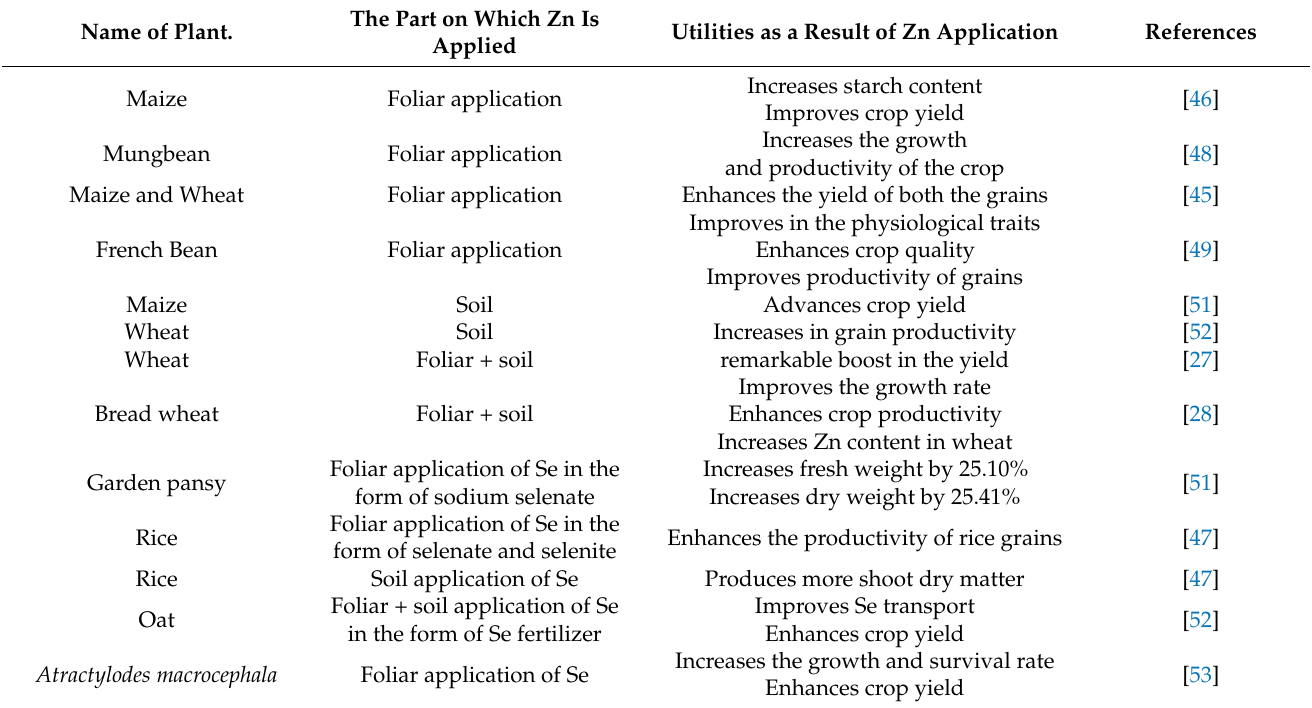
Table 1. Impact of Zinc and Selenium application on plant leaves and